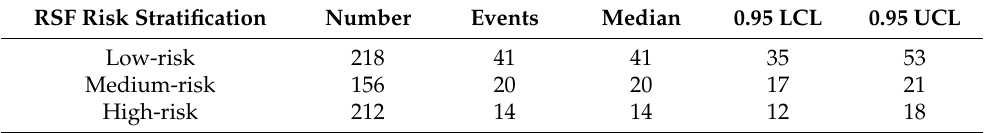
Table 4. The medium survival time (months) of different risk stratifications in the test set.